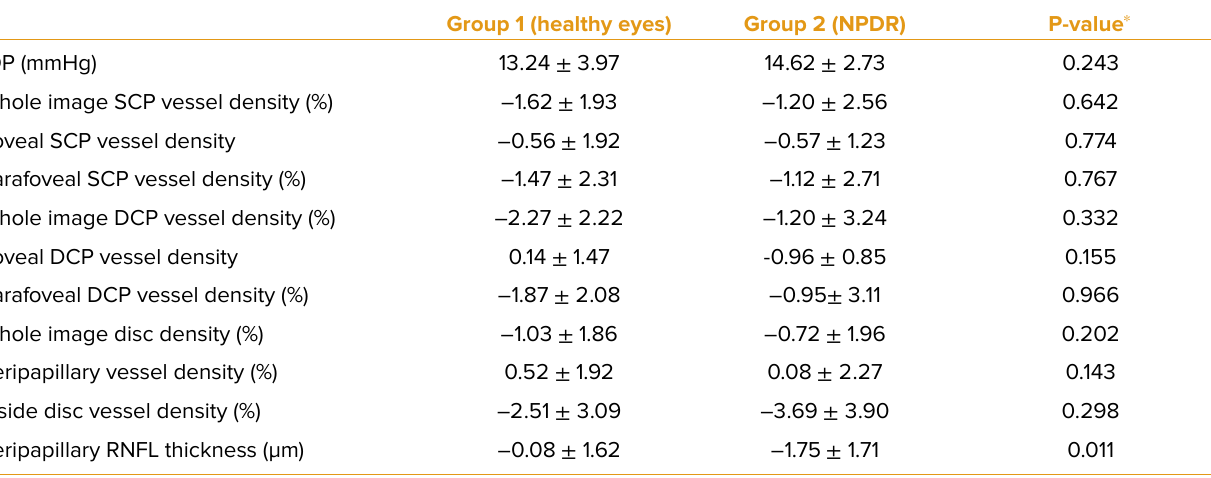
Table 4. Comparison of the measurement changes between healthy eyes and eyes with nonproliferative diabetic retinopathy after acute rise of intraocular pressure after adjustment for